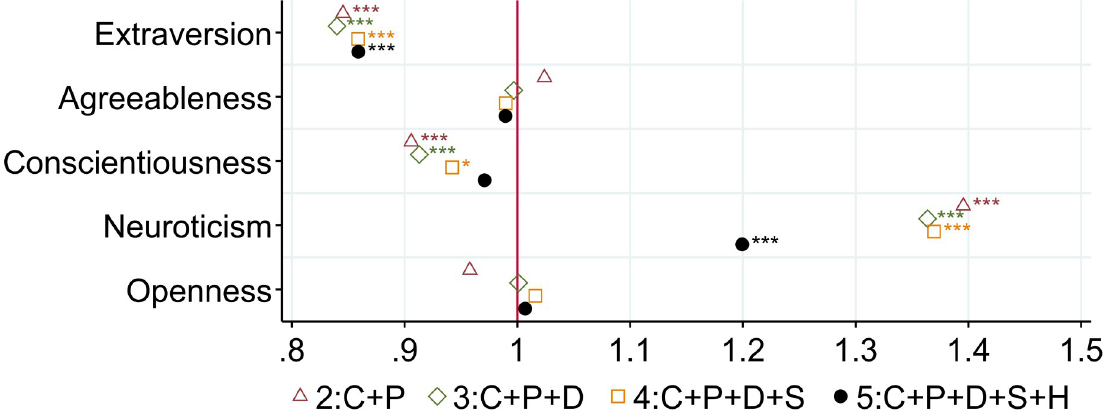
Fig 2. Loneliness at age 50+: The role of personality traits. Note: The figure displays odds ratios of the five scores of personality traits for four different specifications. Specification (2) includes P, a vector of the five scores of personality traits (extraversion, agreeableness, conscientiousness, neuroticism, openness); C, a vector of childhood circumstances (wealth; health; quality of the relationship with mother, father, and friends; importance of religion); and I, country-specific fixed effects. Specification (3) includes (2) and D, a set of individual socioeconomic and demographic variables at age 50+. Specification (4) includes (3) and S, social support, activities, and network variables at age 50+. Specification (5) includes (4) and H, a vector of individual health information at age 50+. Reading example: In the full specification, an increase of 0.5 in the score of neuroticism increases the odds of loneliness by 1.20. The pseudo R 2 and the proportion of correctly specified outcomes are respectively for each specification: (1): 0.0364; 82.89%, (2): 0.0600; 82.99%, (3): 0.0864; 82.96%; (4): 0.1181; 83.39%, (5): 0.1699; 84.09%. � p < 0.05, �� p < 0.01, ��� p <